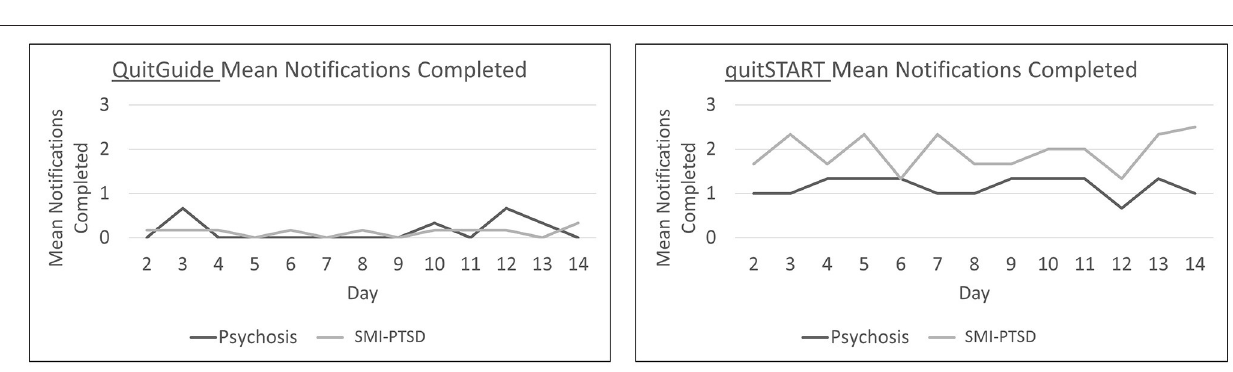
FIGURE 4 | Mean daily app interactions for participants with psychosis and SMI-PTSD.